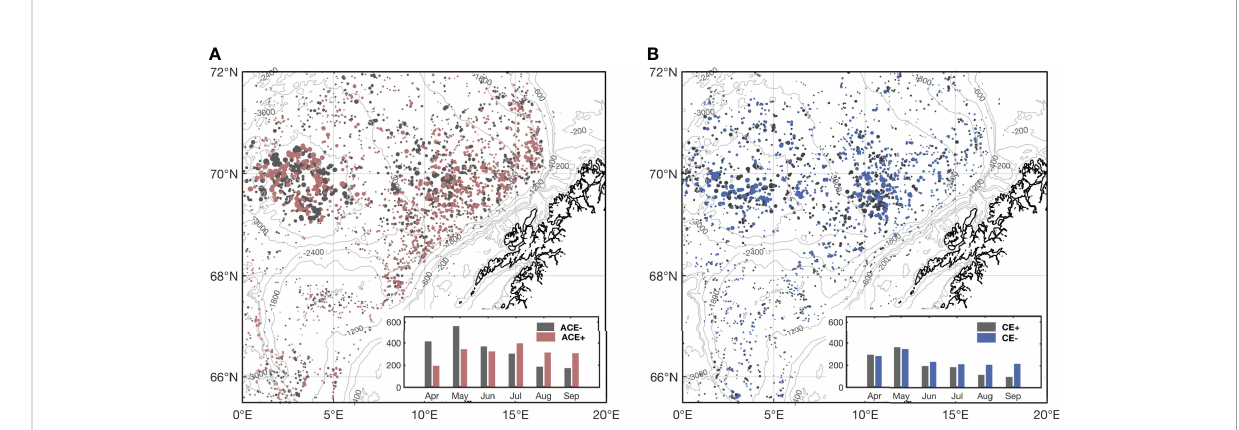
FIGURE 2 Location of identi fi ed (A) 3,841 snapshots of ACEs and (B) 2,727 snapshots of CEs covered by available ocean color data in the northern Norwegian Sea during April to September 2000-2020. (A) The gray and red dots represent ACEs with reduced CHL inside (ACE-) and ACEs with elevated CHL inside (ACE+), respectively, and (B) the gray and blue dots represent CEs with elevated CHL inside (CE+) and CEs with reduced CHL inside (CE-). The size of dots represents the relative magnitude of EI. Monthly numbers of the ACE-, ACE+, CE+, and CE- are shown in the